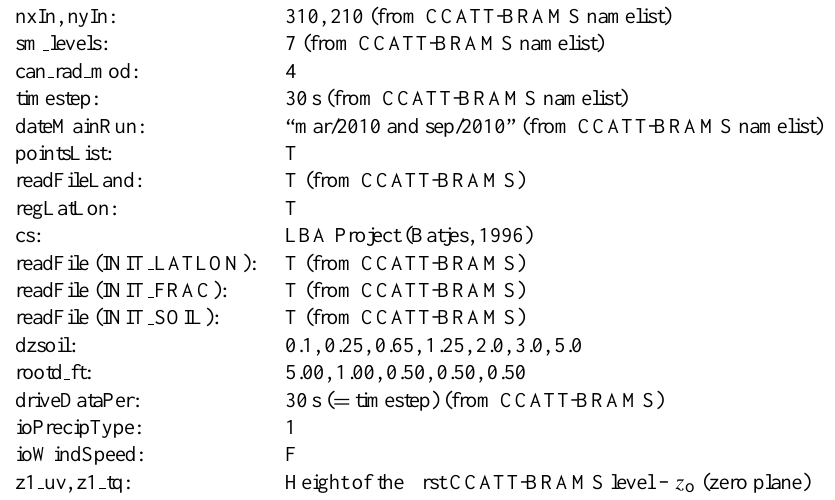
Table 2. Main parameters in the JULES namelist that were changed in relation to the example point loobos example.jin (included in jules 3.0